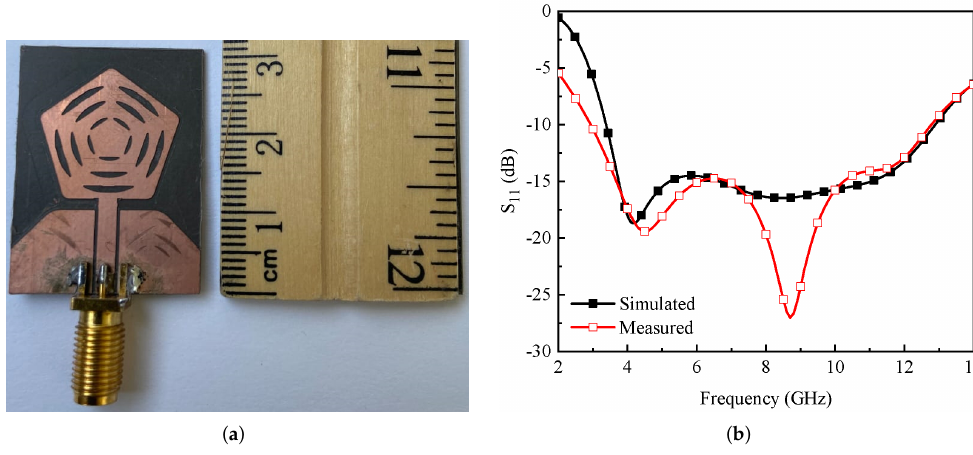
Figure 7. ( a ) Fabricated prototype. ( b ) Simulated and measured S 11 of the proposed CPW-fed pentagonal fractal